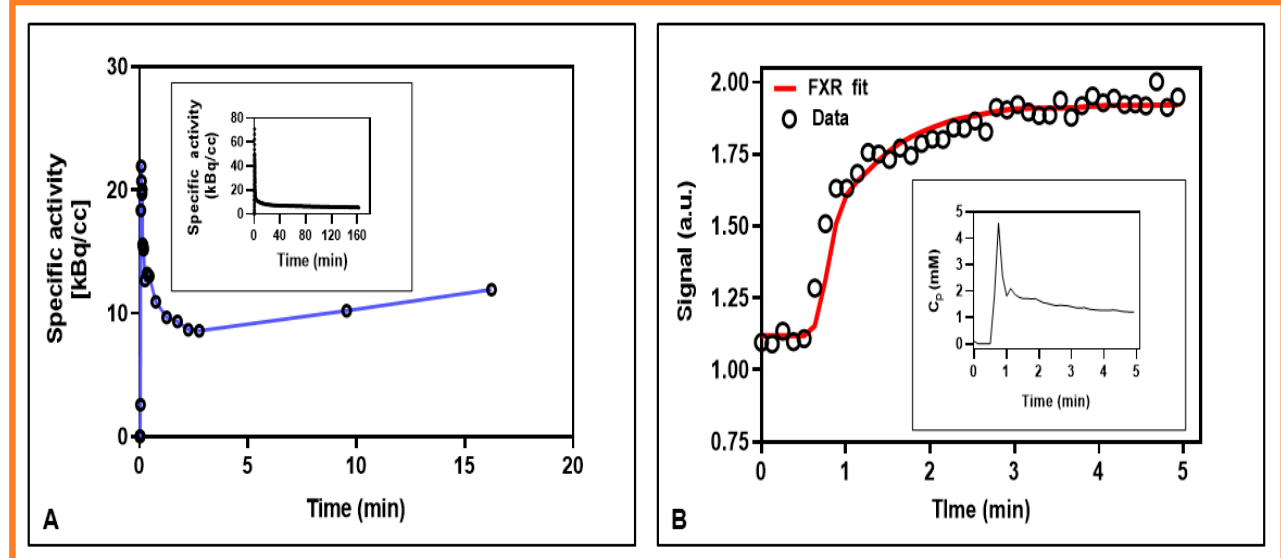
Figure 2. Representative multimodality imaging signal plots with time for data obtained from the metastatic neck lymph node in a patient with head and neck squamous cell carcinomas. ( A ) Measured mean FMISO-PET/CT time-activity curve (circles) data connected with a solid line (blue), and the corresponding input function (in the inset). ( B ) Signal intensity time curves fitted with the fast exchange regime (FXR) model. The circle (black) and solid line (red) represent the data and FXR model fit. Insert: Plasma contrast agent concentration, C p with time.